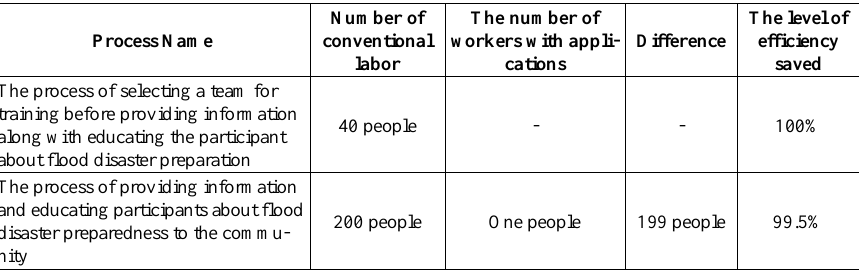
Table 8. Effectiveness based on the